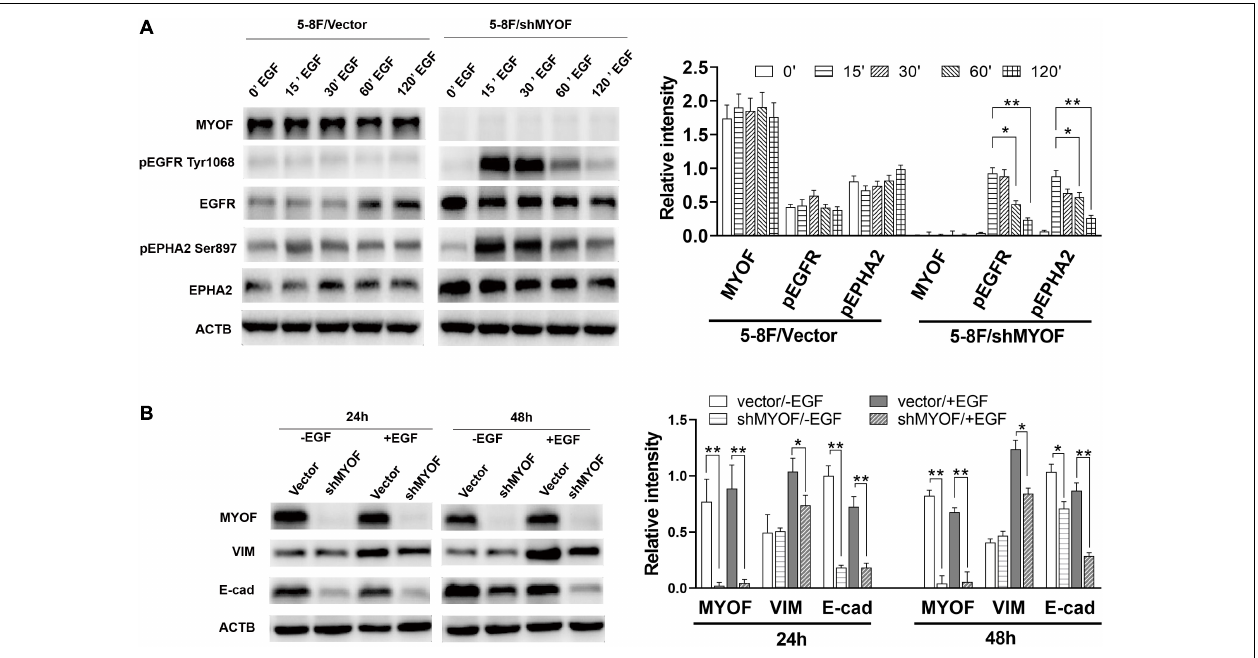
FIGURE 5 | Myoferlin knockdown influences membrane receptor activity and EMT in NPC cells. (A) Western blot analysis of time-dependent expression and phosphorylation level of EGFR and EPHA2 following EGF stimulation and myoferlin knockdown. (B) MYOF knockdown inhibited EGF-induced VIM expression. The density of the bands was analyzed by using NIH ImageJ software and normalized by the arbitrary units of b-actin. Data are the means ± SDs of 3 experiments. * p < 0.05 and ** p <